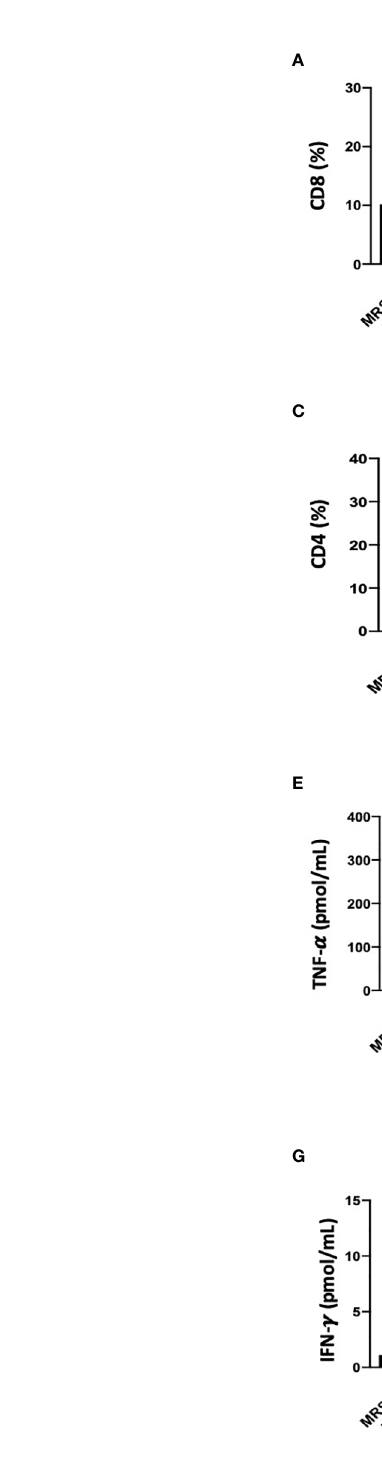
FIGURE 8 P2Y12 or P2Y1 antagonism selectively alter CD4 and CD8 cell populations and cytokine secretion in human PBMCs. Cells isolated from female (black) and male (white) donors were stimulated with LPS (right panel) or left unstimulated (left panel) for 72 h. Cells isolated from male (A-C-E-G) and female (B-D-F-H) donors were stimulated with LPS (right panel) or left unstimulated (left panel) for 72 hours. Unstimulated cells were cultured without stimuli. Cells were exposed MRS2279 (100µg/mL) or ticagrelor (100µg/mL). Negative control did not receive any treatment. Cell populations positive to CD8 (A-B) or CD4 (C-D) were determined using fl ow cytometry. Data are expressed as % of expression ± S.E.M. (*p < 0.05, n=6). Cytokine levels in the culture supernatants were determined for TNF-alpha (E-F) and IFN- g (G-H) . The groups analyzed were: negative control, MR2279-treated, and ticagrelor-treated cells. Cells were stimulated with LPS (right panel) or left unstimulated (left panel) for 72 h. Values are expressed in pg/ml; means ± S.E.M. are plotted (*p < 0.05, n =